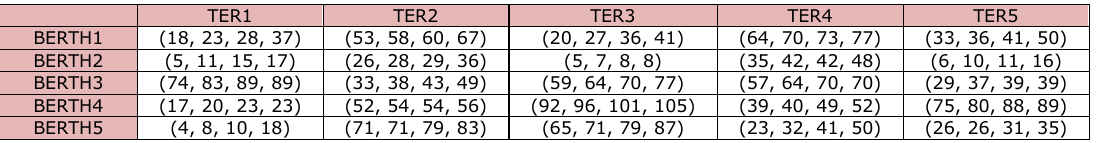
Table 2. “Available Capacity of each Terminal in a Berth”.